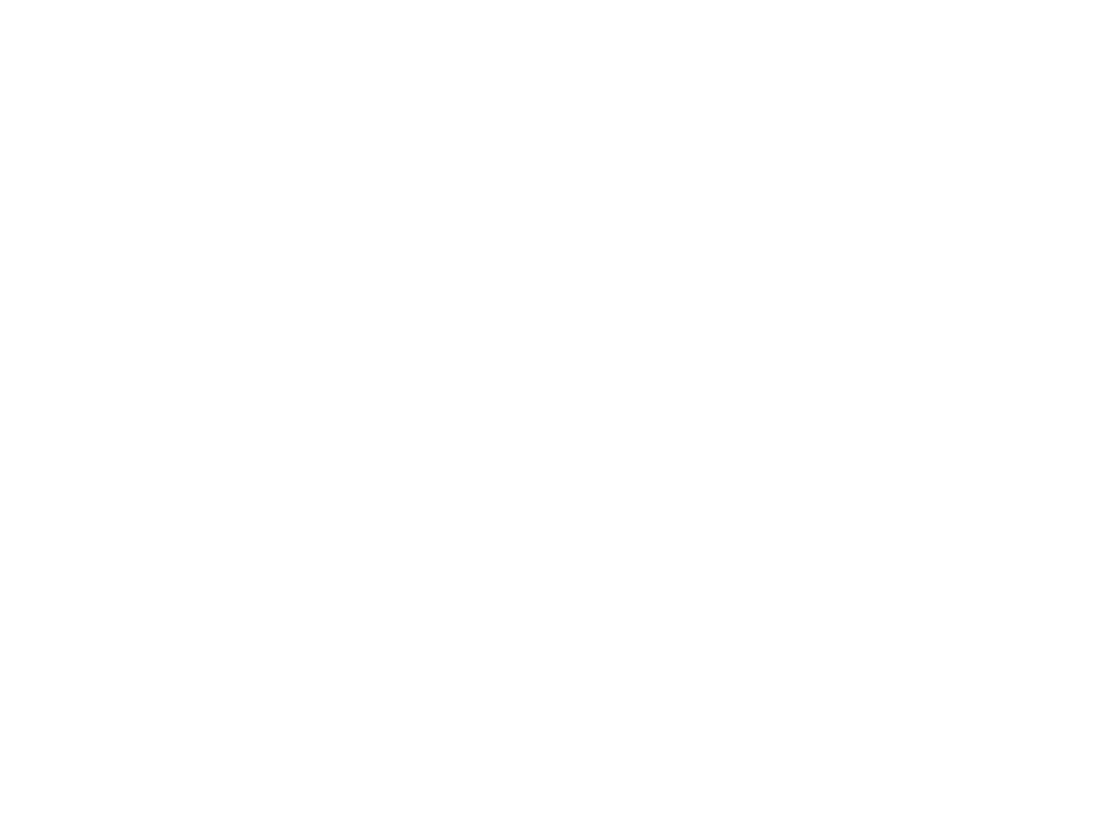
. ε is the strain rate (s − 1